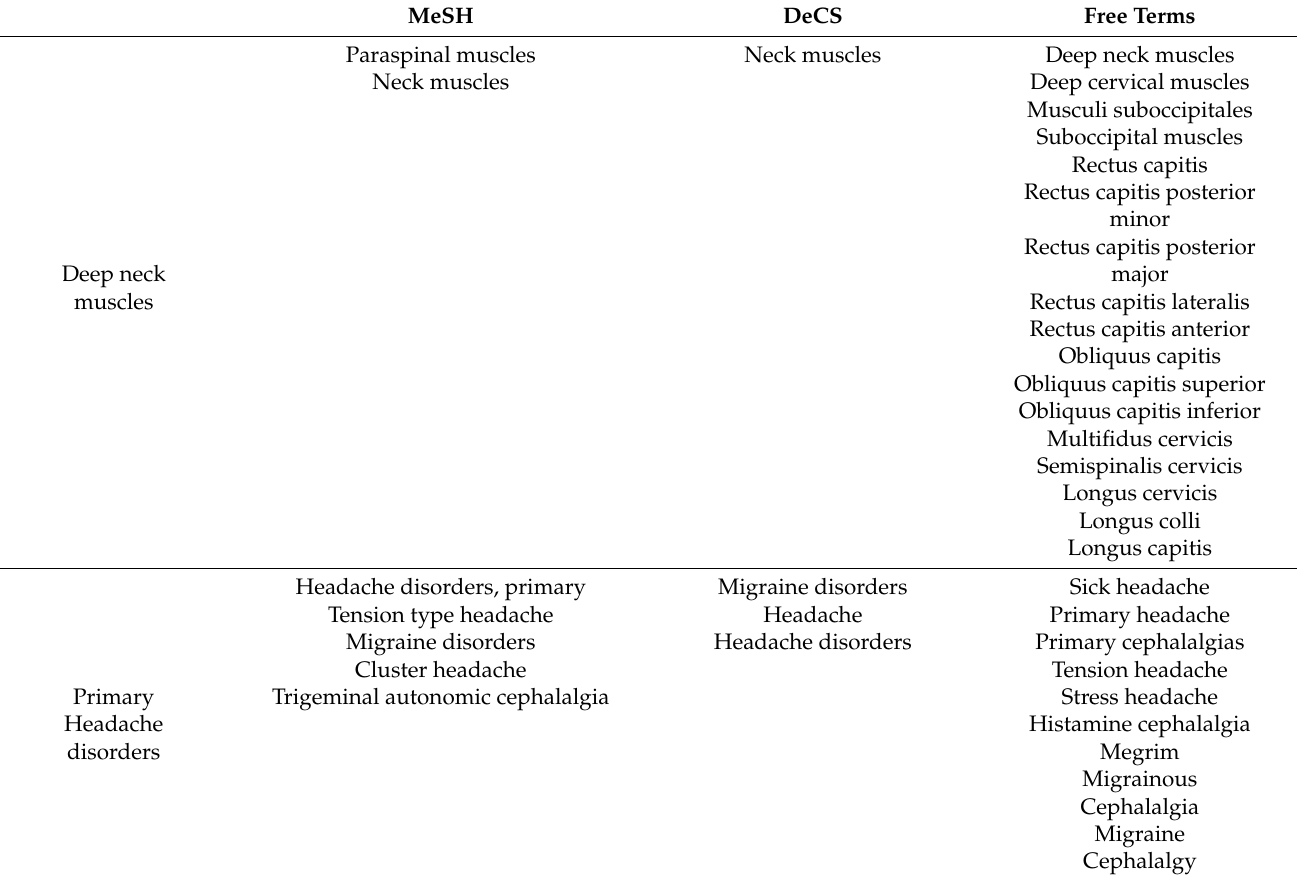
Table A1. Search terms. This table shows the different terms used in the database